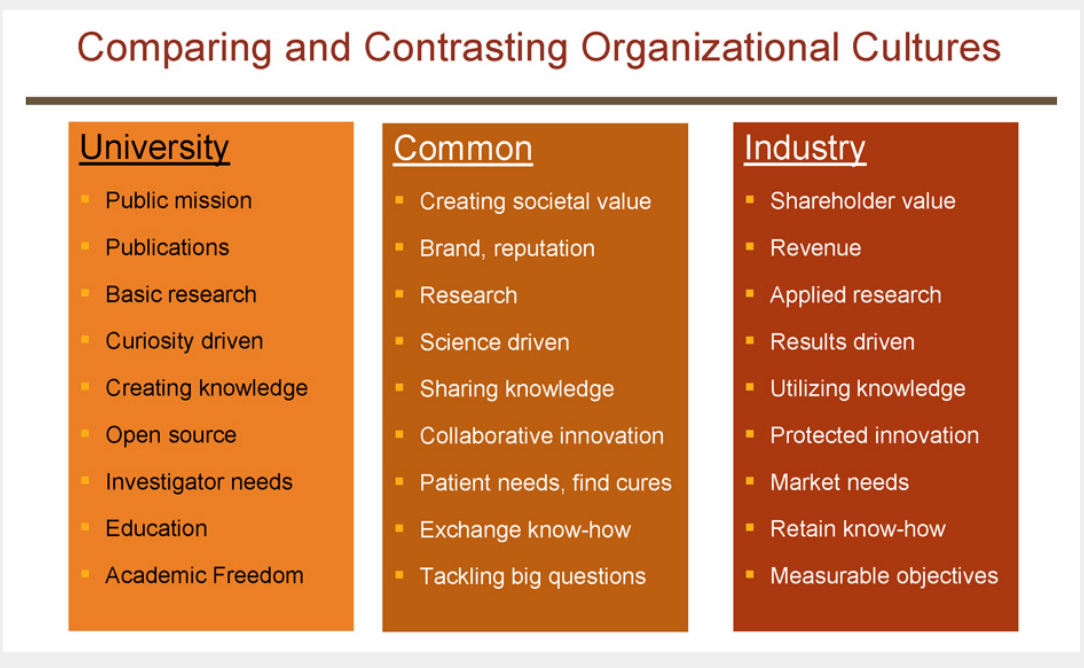
Comparison of the organisational cultures in universities and in the pharmaceutical industry. The traditional view on the collective processes and values that make up culture are indicated in the left and the right panels. Successful collaborations defy the polarised view, have a shared purpose and follow a paradigm based on common beliefs and assumptions (middle